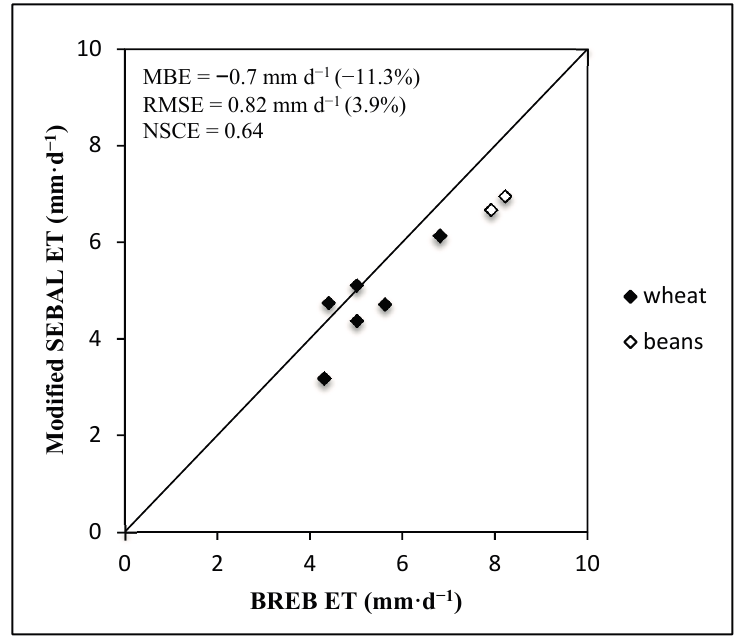
Figure 4. Comparison of SEBAL-A ET and BREB ET for beans and